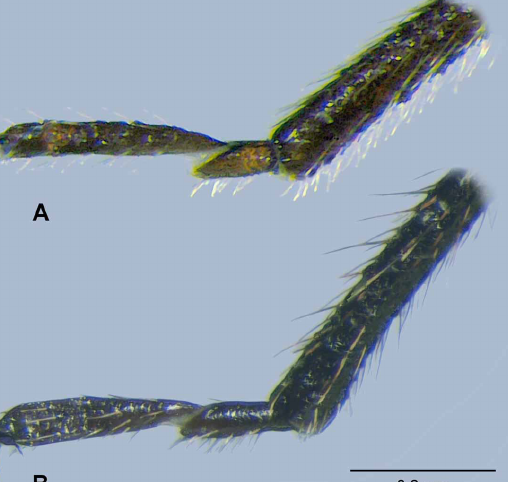
Fig. 87. Hind tarsus, showing length and form of second segment. A . Cinara (Cinara) nuda Mordvilko, 1895 B . C. pinea (Mordvilko,